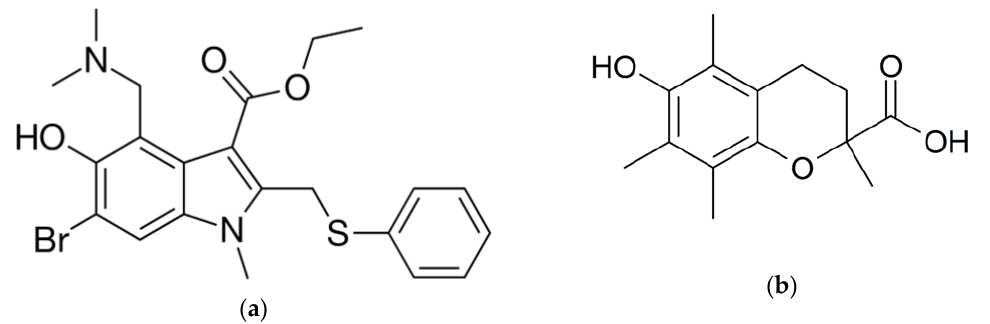
Figure 1. The structures of ( a ) Umifenovir and ( b ) Trolox.